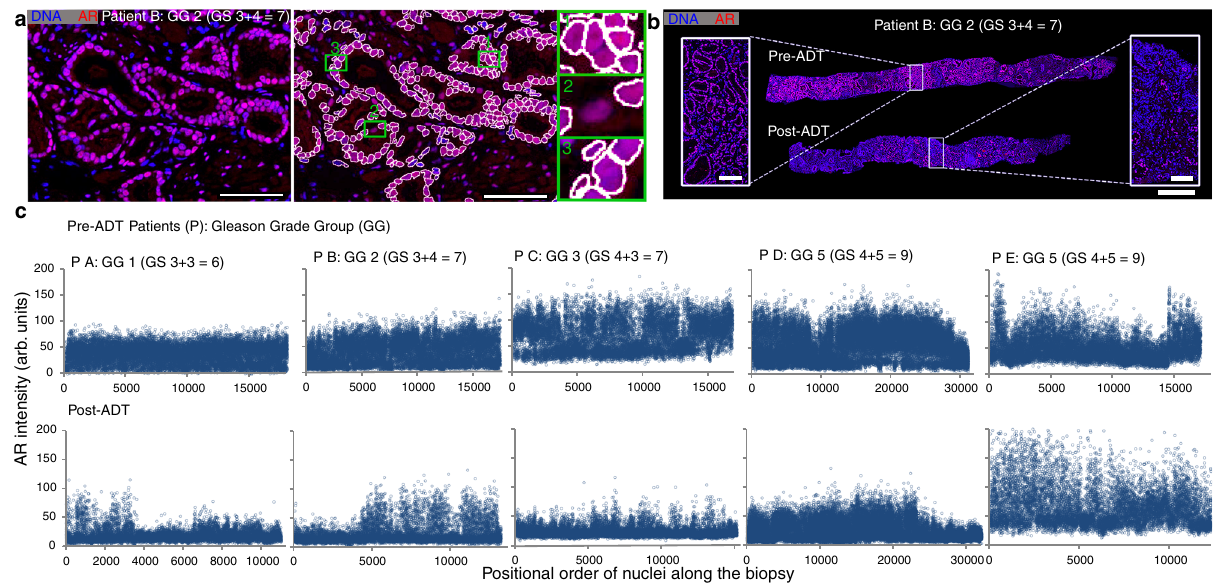
Fig. 1 | IHC images for the AR activity in epithelial nuclei performed on needle biopsies pre- and post-ADT. a Prostate tissue from a paraf fi n-embedded biopsy stained for the AR (red) and DNA (blue). AR levels in epithelial cell nuclei pre- and post-ADT were extracted, encircled in white (right panel; for details see Online methods). Scale bars 100 µ m. Insets 1 – 3 show examples of occasional mis- classi fi cations that may occur using the algorithm. Inset 1 shows failure of separ- atingtwonuclei.Inset2showsfailureofnucleusdetectionduetolowDNA-staining intensity. Inset 3 shows misclassi fi cation of stromal cell nuclei as epithelial, due to